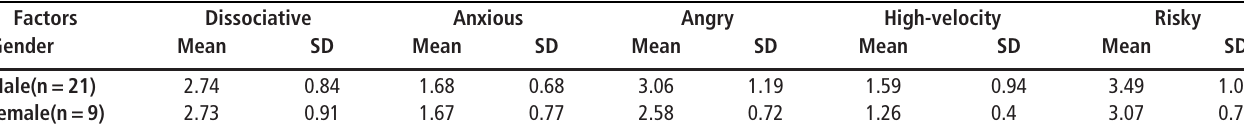
Table 1 MDSI-C Factors according to gender Factors